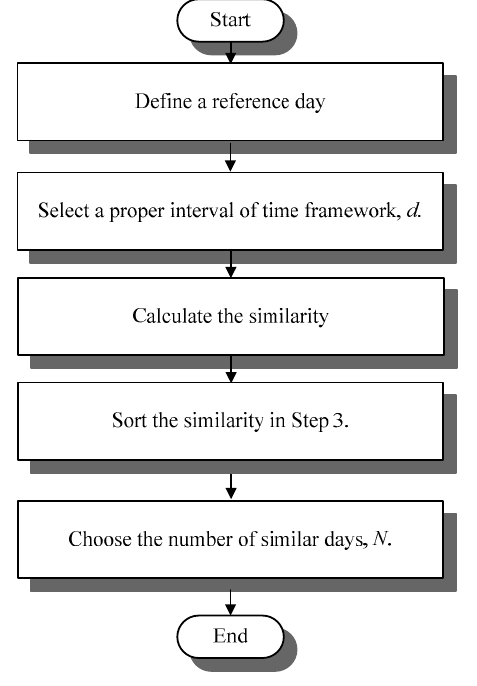
Figure 3. Similar day selection flowchart.